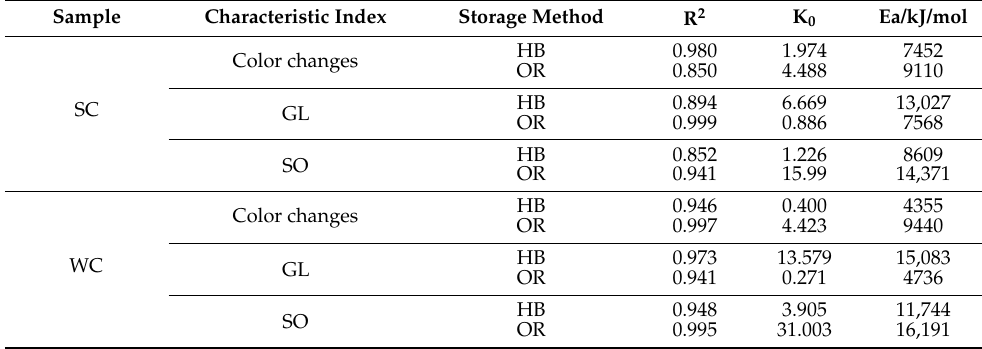
Table 1. The fitting results of the kinetic models at different temperatures and the predicted shelf- life results.